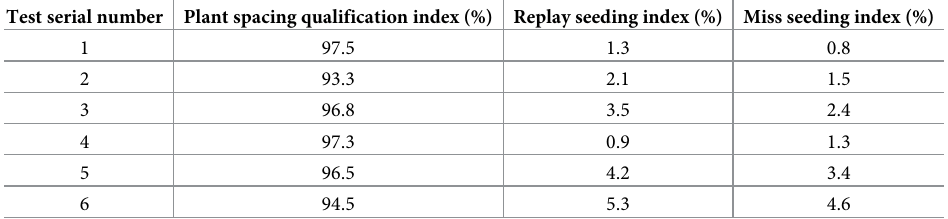
Table 2. Calculation results of single-grain operation test